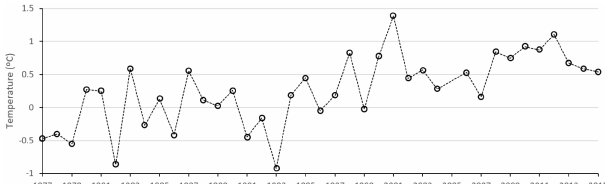
Figure 14. Estimated mean annual air temperatures at the sum- mit of Djebel Toubkal (4167ma.s.l.) obtained from extrapolation of temperatures from Menara (Marrakesh) using a lapse rate of − 0.59 ◦ C100m − 1